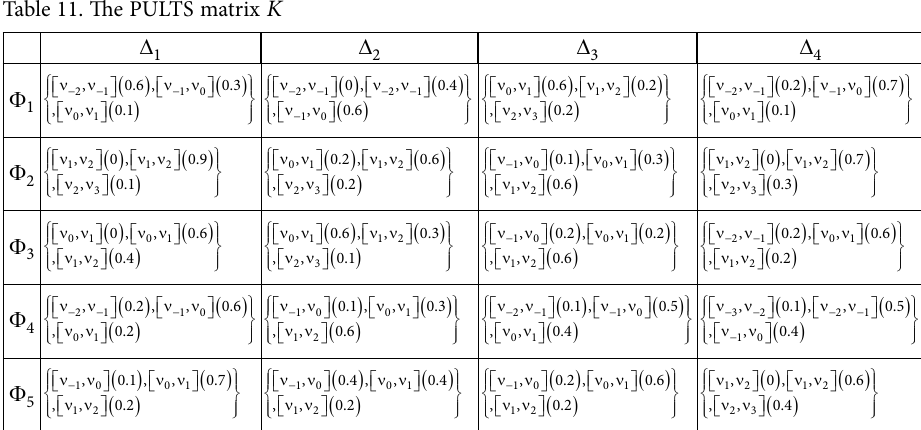
Table 11. The PULTS matrix K